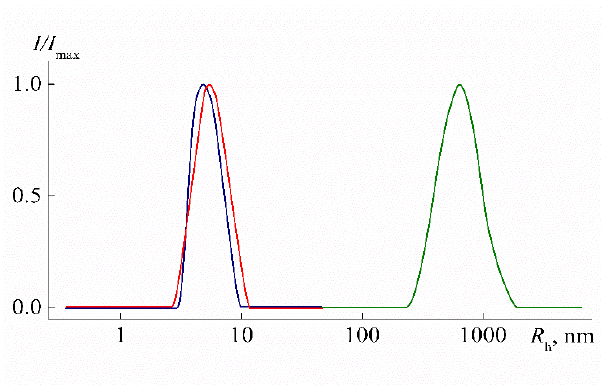
Figure 4. Relative intensity I / I max of scattered light vs. the size of scattering species R h-D for PEI-1 in chloroform (blue) at c = 0.0379 g cm –3 , in water at 10 °С (red) and 19 °С (green) at c = 0.0374 g cm –3 . I max is the maximum of light scattering intensity for studied solution.